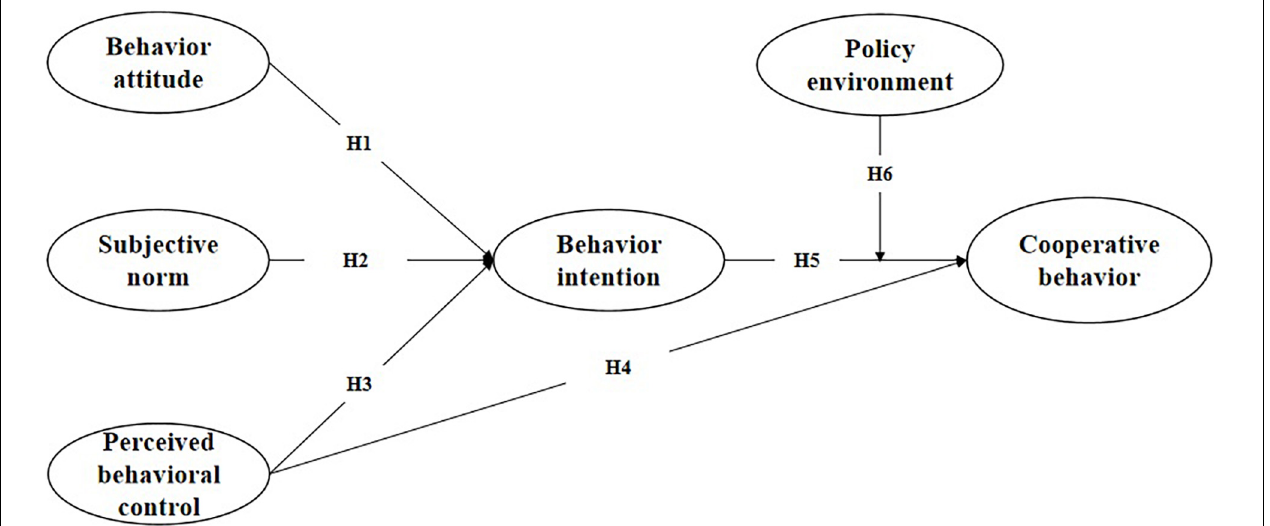
FIGURE 1 | Research